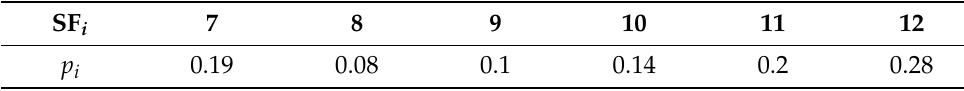
Table 7. Probabilities of an end-device using a specific